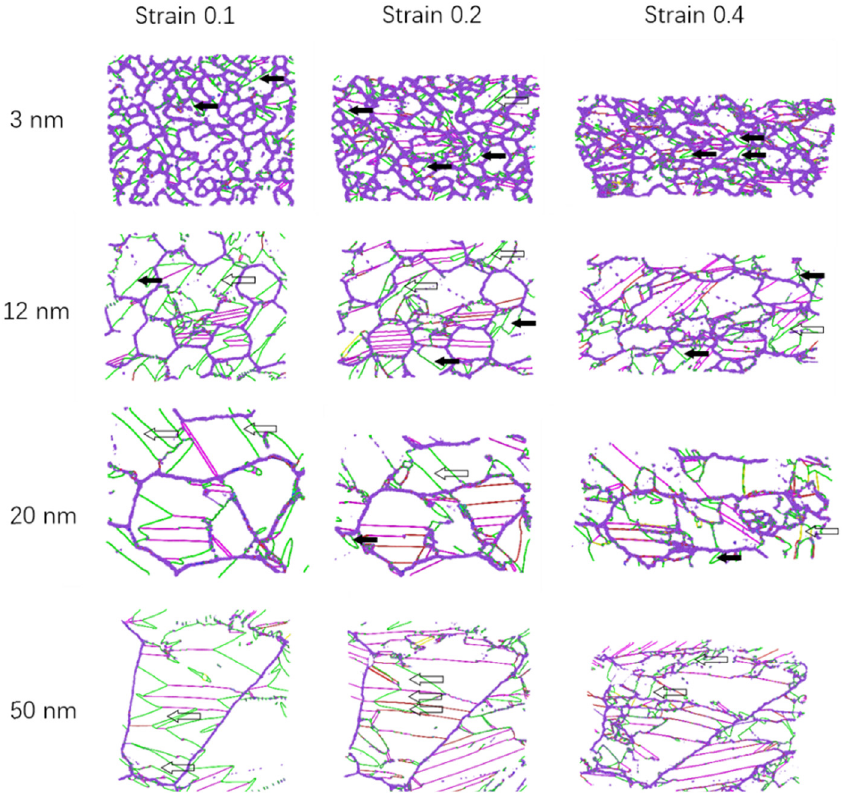
Figure 4: Snapshots of the MD samples with di ff erent grain sizes during the uniaxial